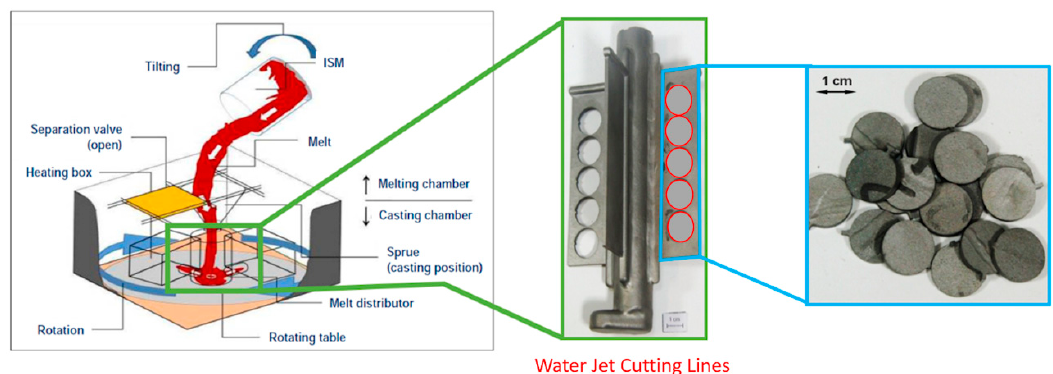
Figure 1. Principal centrifugal casting layout (Leicomelt TP5) ( left ); cast part wax model providing 4 rectangular plates, water jet cutting lines in red ( center ); water-jet cut of in vitro test specimen ( right ). Discs were 14 mm in diameter and 2 mm in height.